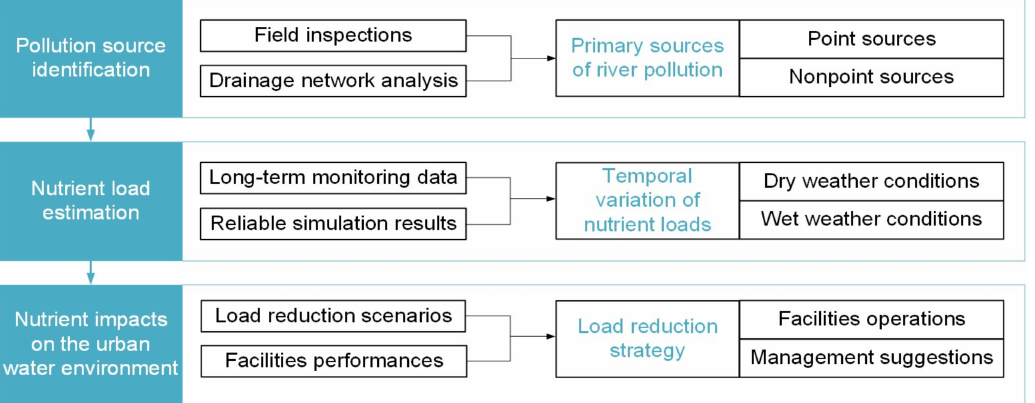
Figure 1. Methodology for evaluating nutrient